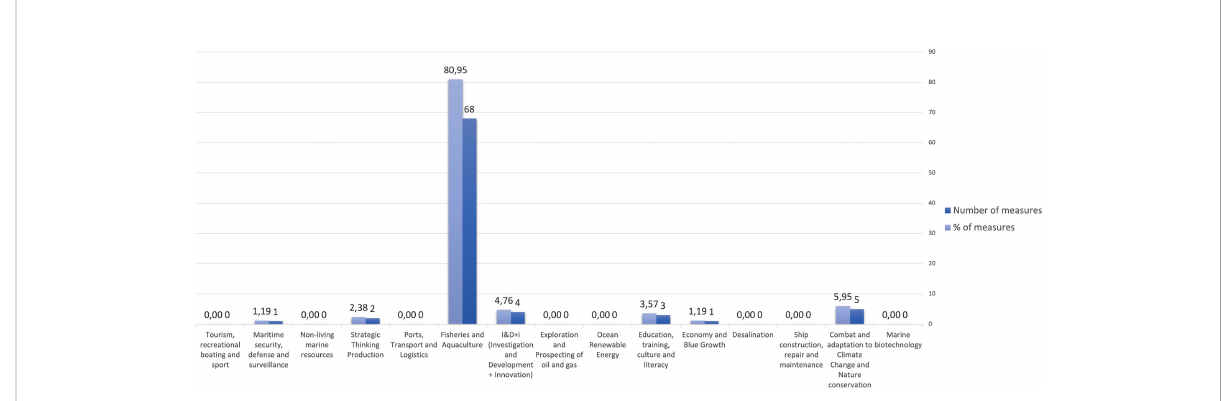
FIGURE 7 Number of identi fi ed measures, and corresponding percentage, by socio-economic sector, of Spain ’ s National Ocean Strategy. Source: Created by the author.